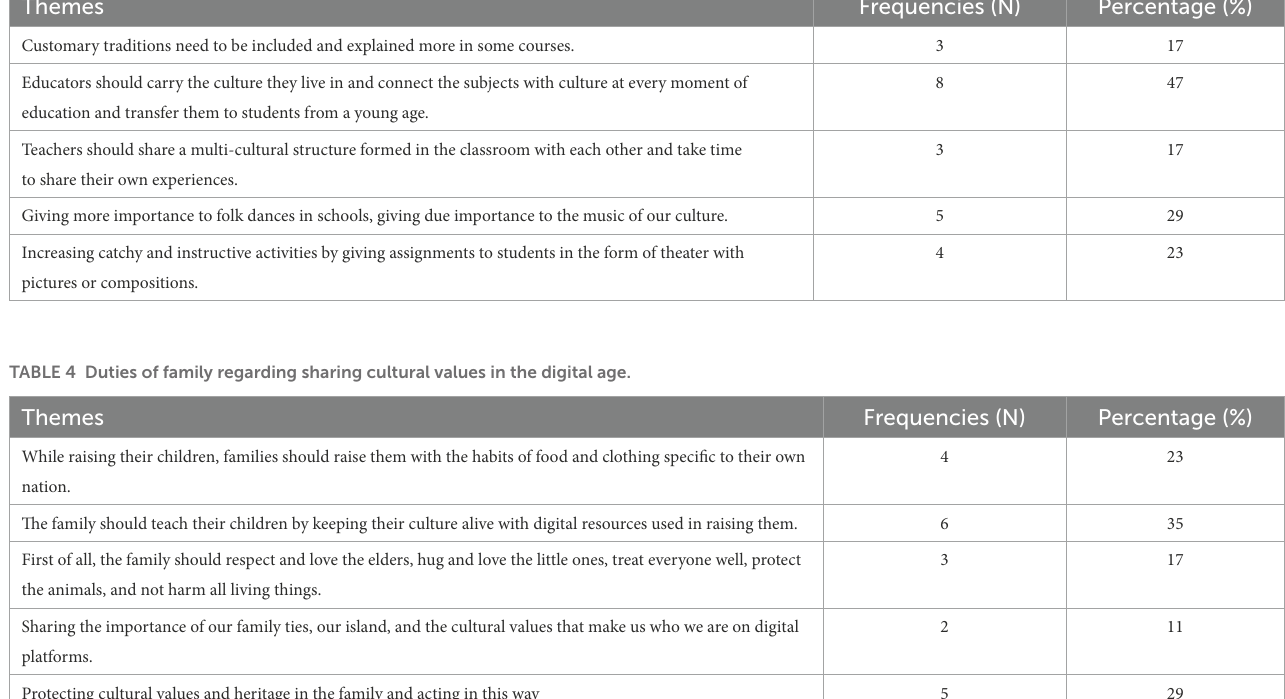
TABLE 3 Duties of educators regarding sharing cultural values and heritage in the digital age. Themes Frequencies (N)